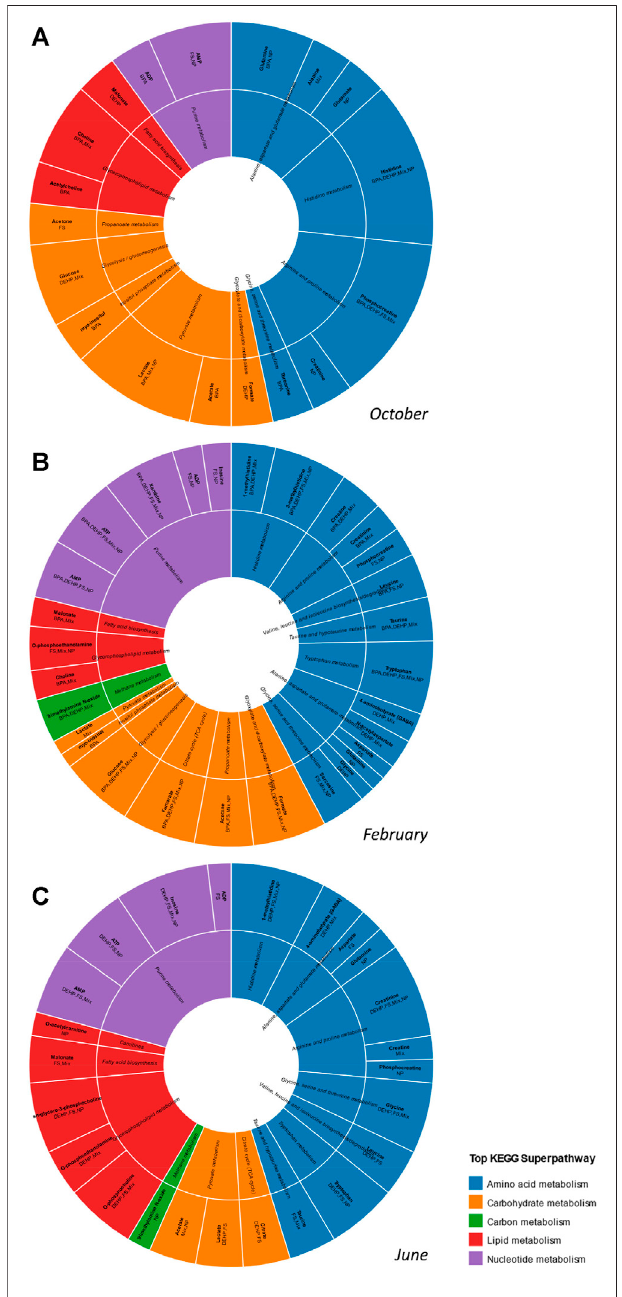
FIGURE4| Effectsofcontaminanttreatmentsonmalegold fi shmidbrain metabolomeacrossseasons.Sunburstdiagramdepictingmetabolitesaltered byindividualcontaminantsorthetertiarymixtureinmidbrainin (A) October (B) Februaryand (C) June.MetabolitesdepictedarethosewithVIPscore > 1 in pairwise control vs treatment O2PLS-DA modeling. The diagram includes annotation of speci fi c contaminant treatments found to alter each metabolite. Metabolites and associated biochemical pathways are color coded by KEGG